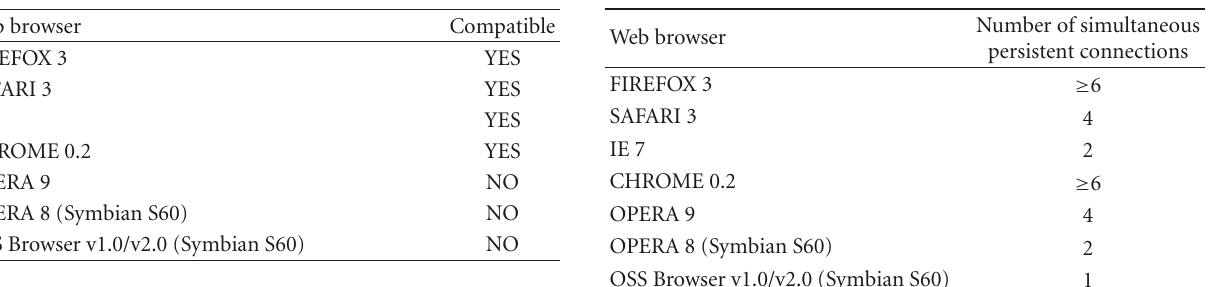
Table 1: Compatibility of the web application developed for the CMU units with di ff erent existing web browsers.